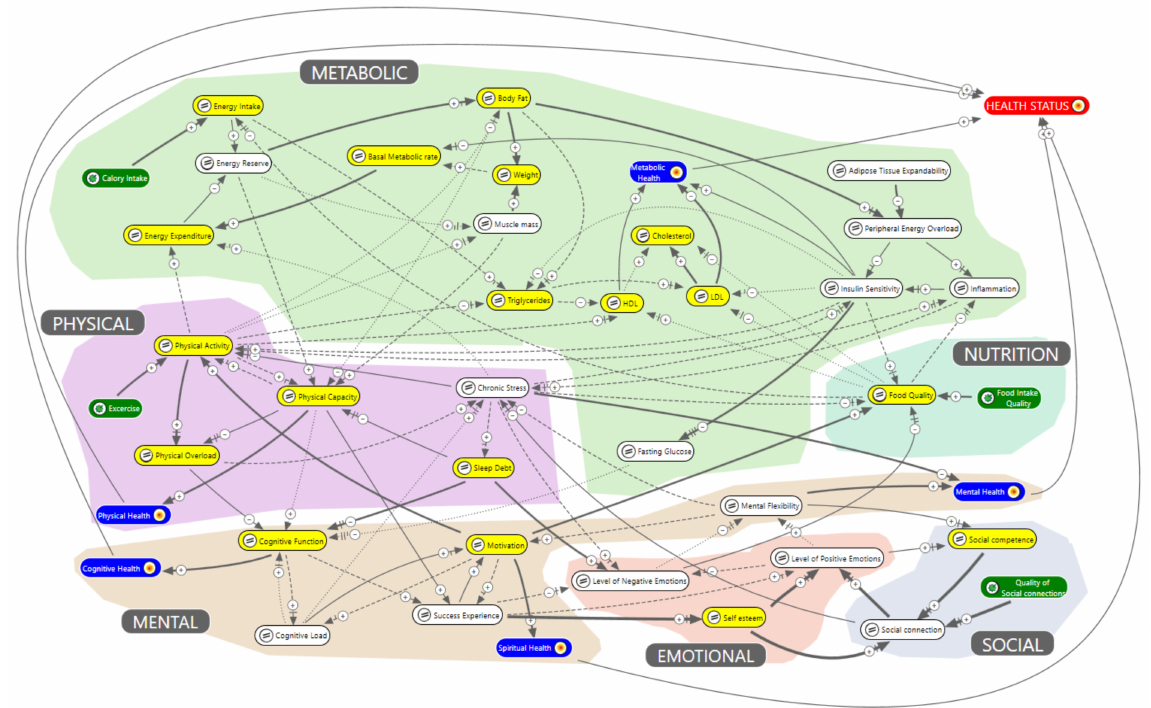
Figure 1. Systems health model of obesity. Variables are connected with arrows indicating the direction of the relationship. The thickness of the arrows indicates the strength of the relationship, small lines near the head of the arrow indicate the speed of the relationship, a plus or minus indicates a positive (reinforcing) or negative (counteracting) relationship. The model consists of several domains identified by colored clouds and by the grey labels: metabolic, physical, nutrition, mental, emotional, and social. The variables in yellow are the ones that will be monitored. Green variables can be changed by the individual; the blue and red ones are health goals